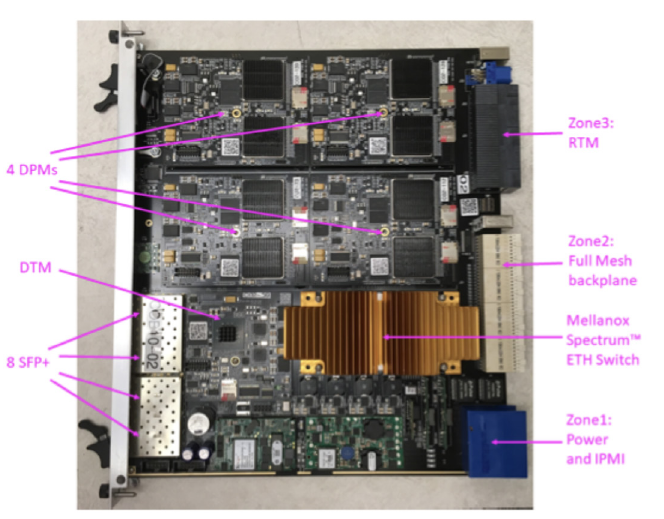
Figure 2. An illustration of a COB. Four DPMs and one DTM daughter boards are installed to the COB. Connectors of the RTM, full mesh backplane and power supply are shown in the right hand